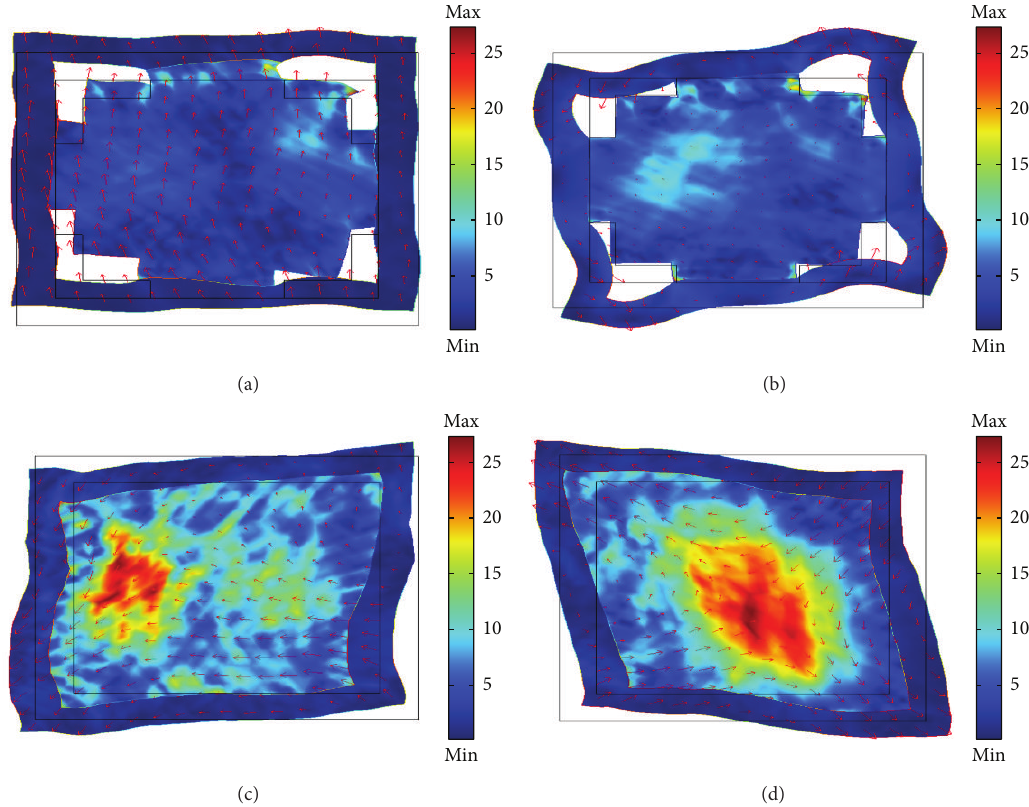
Figure 4: Eigenmodes shapes and displacement vector fields of the modes marked in Figures 2 and 3 correspond to points A, B, C, and D,